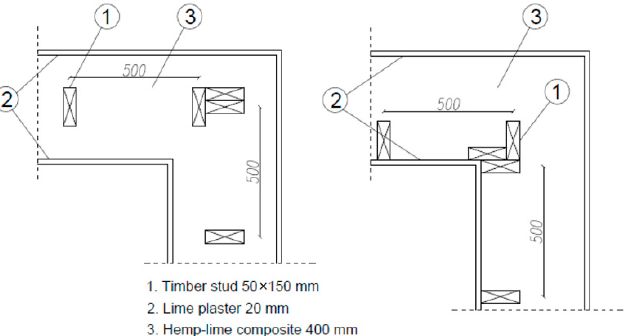
Figure 3. External corners with the timber frame located centrally in relation to wall thickness (on the left ) and located on the inner side of the wall (on the right ).